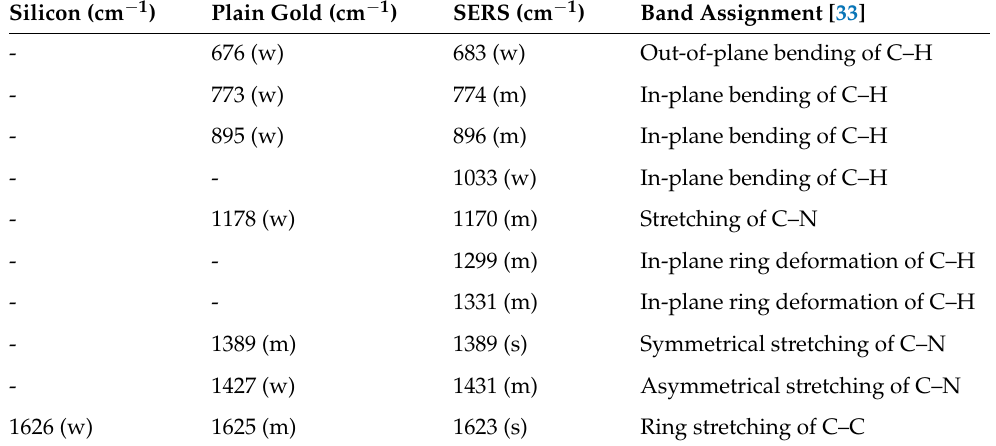
1625 (m) 1623 (s) Ring stretching of